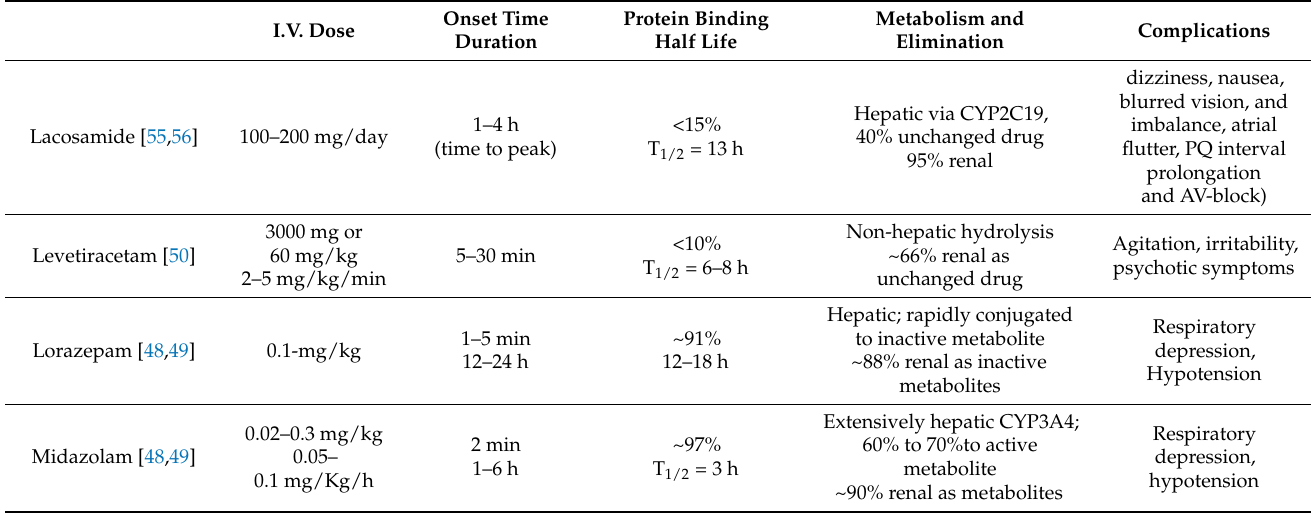
Table 1. Pharmacology of anticonvulsant